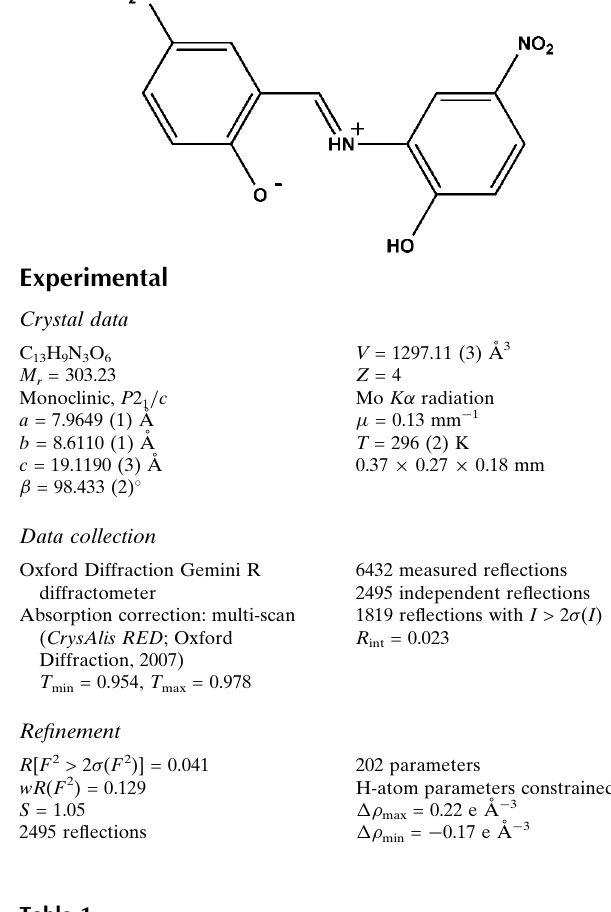
H N O , consists of a 2-hydroxy-5- 13 9 3 6